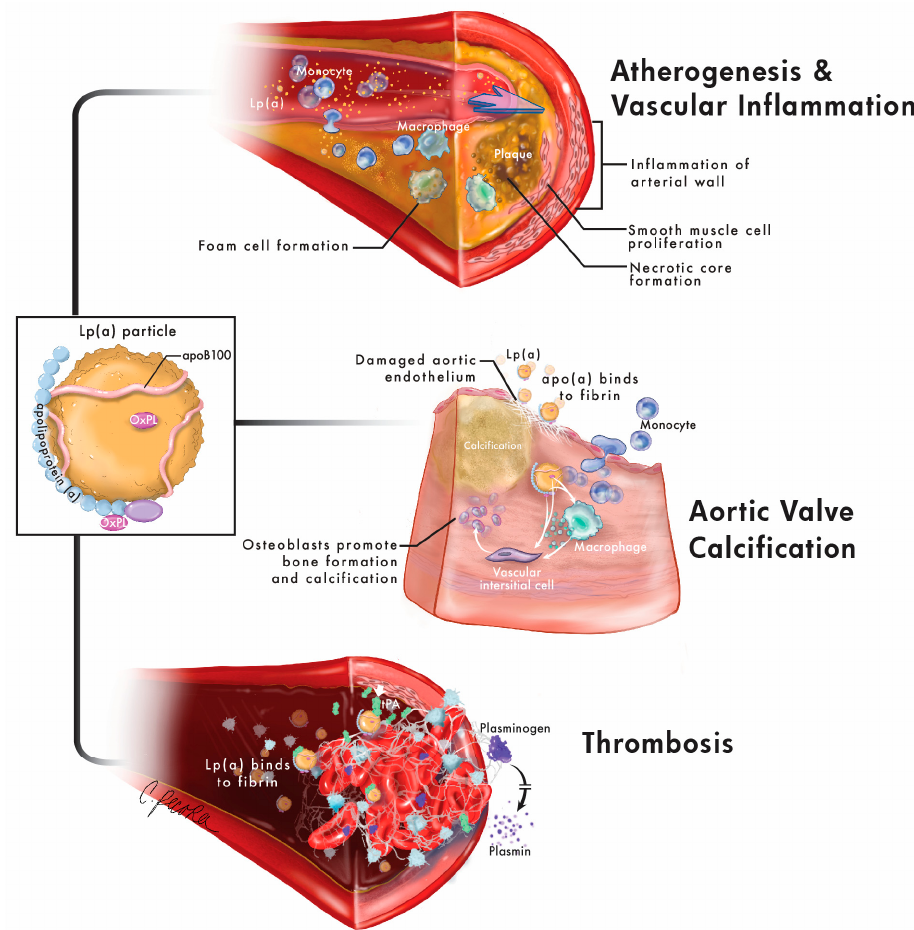
Figure 1. Mechanisms of cardiovascular risk related to Lp(a). Lipoprotein(a) and its individual components are associated with cardiovascular disease through multiple overlapping mechanisms. Lp(a) is composed of apolipoproteinB100 (apoB100) and apolipoprotein(a) (apo(a)), both of which contain oxidized phospholipids (OxPL). The apoB100 contributes to atherogenesis through similar mechanisms as low-density lipoprotein (LDL), including vessel wall binding, smooth muscle cell proliferation, foam cell formation and necrotic core formation. OxPL contribute to vascular inflammation through increased transmigration and cytokine production by monocytes as well as upregulation of inflammatory genes. Lp(a) contributes to aortic valve calcification as apo(a) binds to fibrin on injured aortic endothelium, and OxPL promote calcification and bone formation via vascular interstitial cells and upregulation of reactive oxygen species and proinflammatory cytokines in macrophages. Finally, apo(a) contributes to thrombosis by inhibiting fibrinolysis through competitive inhibition of tissue plasminogen activator (tPA) activation of plasminogen to plasmin and plasminogen binding to fibrin as well as promoting increased platelet activity.